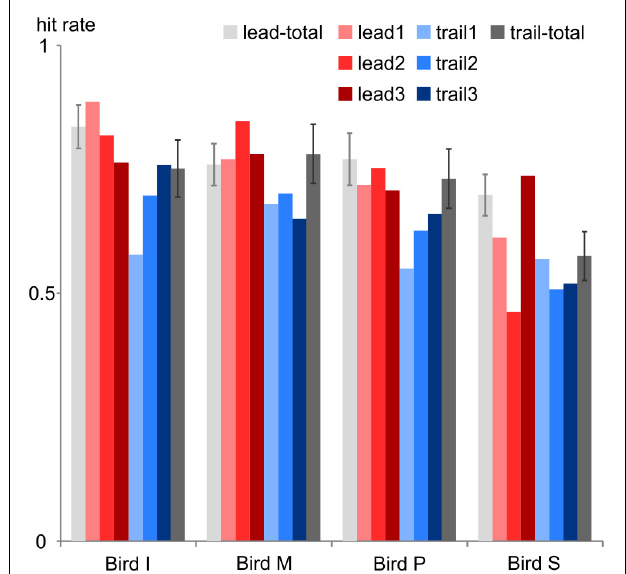
FIGURE 5 | Performance change. The hit rate is shown for each bird during the first 3 leading sessions (lead1–3, red colors) and the first 3 trailing sessions (trail1-3, blue colors) and in comparison to the hit rate across all leading sessions (lead-total, light gray leftmost bars) and trailing sessions (trail-total, dark gray rightmost bars). Error bars: standard